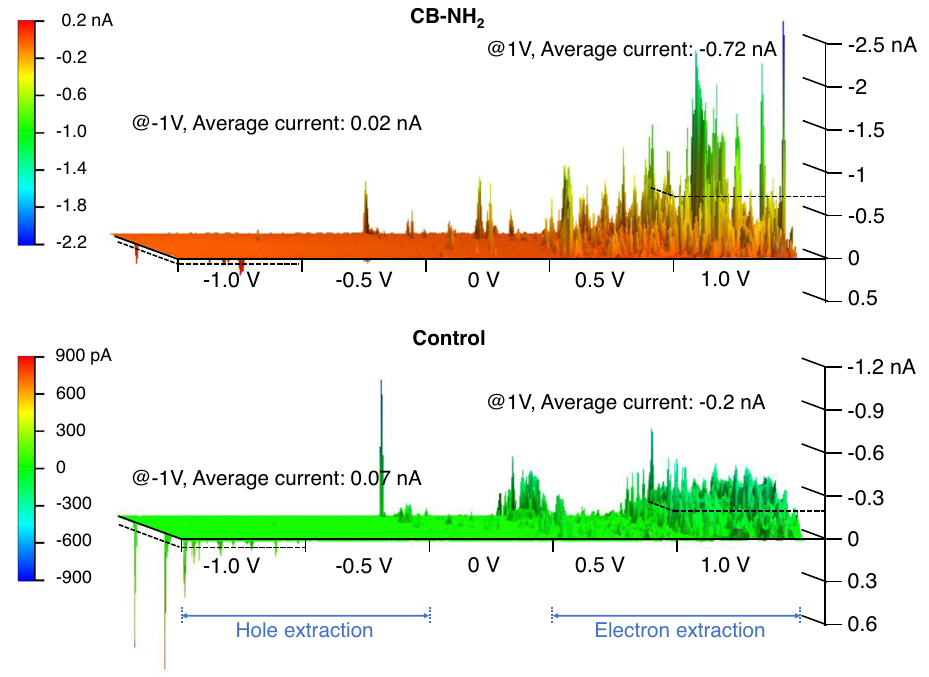
Fig. 6 | Improved electron extraction and hole blocking at perovskite/C 60 interface. 3Dconductive-AFM images (5×5 μ m) ofthe samples with a structureof ITO/MeO-2PACz/Pero/CB-NH 2 / C 60 (CB-NH 2 treated) and ITO/MeO-2PACz/Pero/